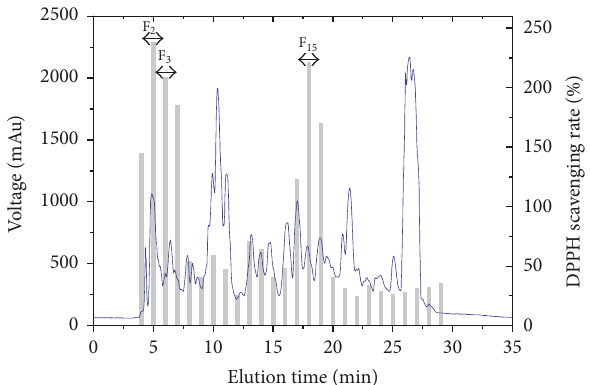
Figure 3: Chromatographicand antioxidant profiles of corn protein hydrolysates using Eclipse XDBC18 semipreparative column. Histogram, DPPH radical scavenging rate per unit weight peptide